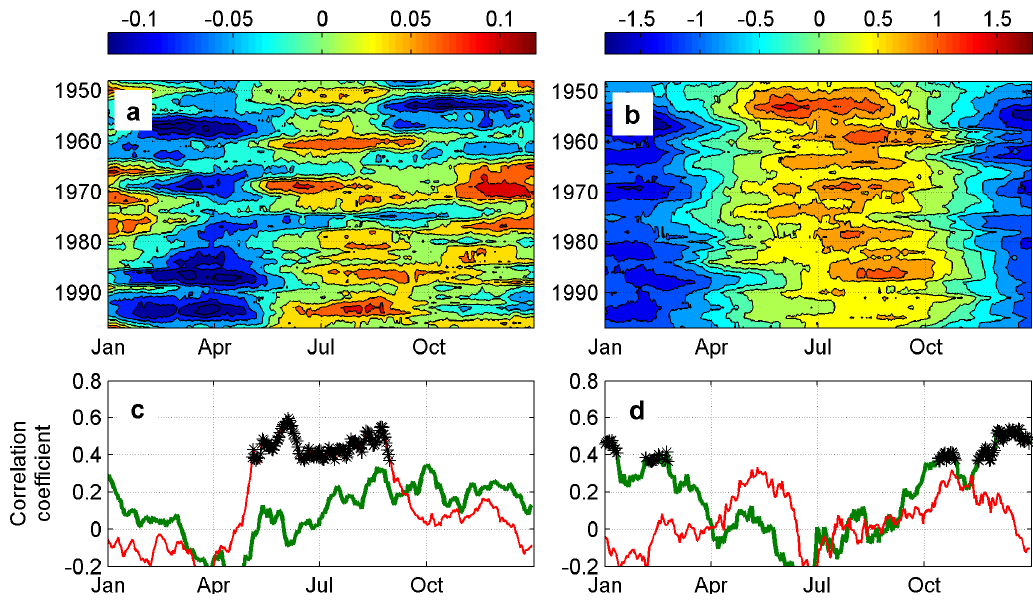
Figure 7. Identification of precipitation characteristics associated with the 8-y and 12-y lake-level cycles. Filtered 120-day moving averages of regional precipitation ( a ) frequency (cid:1842)(cid:3552) (cid:3033) and ( b ) amount (cid:1842)(cid:3552) (cid:3028) ; ( c , d ) Correlations between the precipitation indices (from a and b ) and the 8-y cycle (cid:1856)(cid:1838) (cid:3052)(cid:3045)(cid:3030)(cid:2876) (thick green lines) and 12-y cycle (cid:1856)(cid:1838) (cid:3052)(cid:3045)(cid:3030)(cid:2869)(cid:2870) (thin red lines). Black stars indicate significant correlations at 1%